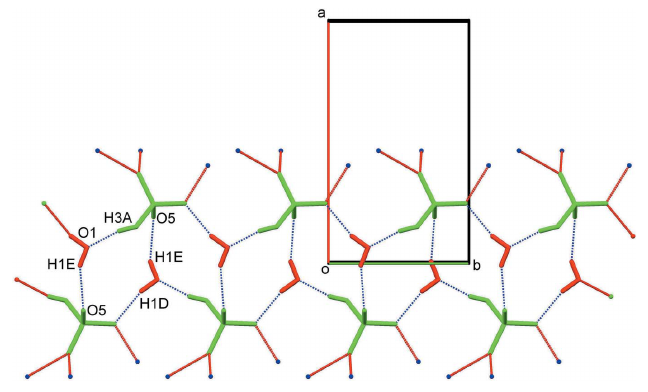
Table 1), with the O1—H1 E (cid:2) (cid:2) (cid:2) O5 hydrogen bond appearing